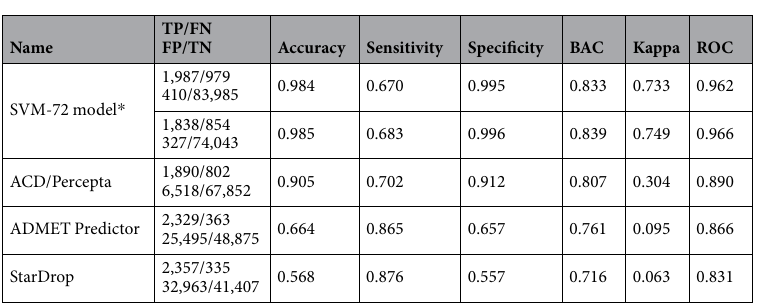
Table 4. Statistics of the SVM-model and commercial models for the test set. * For the SVM model, the first row represents the results for all test set compounds, and the second row represents the results for 77,062 compounds used with all three commercial software programs to predict the hERG inhibitory